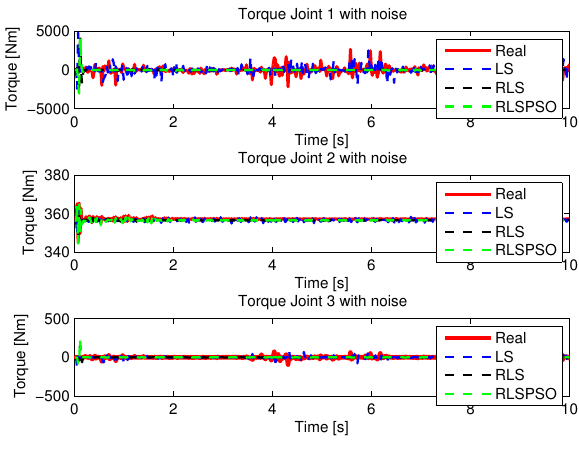
Figure 45. Torque with noise